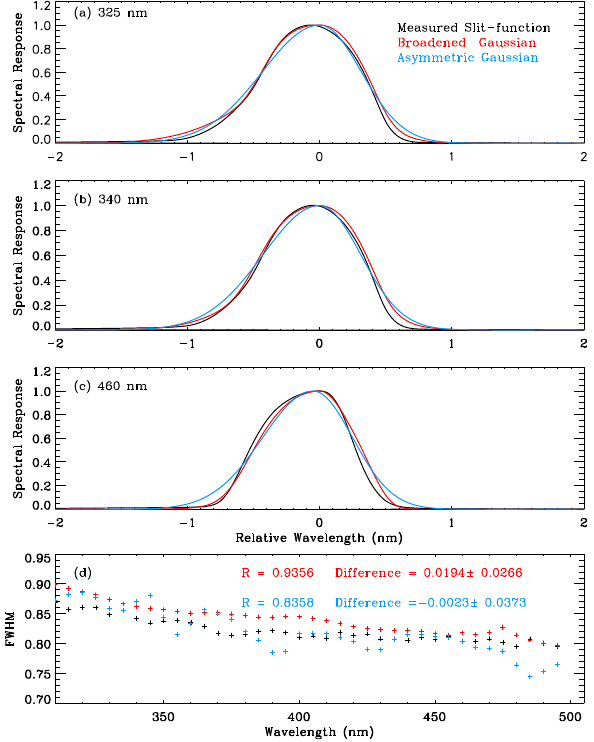
Figure 4. Comparison of derived ACAM asymmetric Gaussian (blue) and broadened Gaussian (red) slit functions with laboratory- measured slit functions (black) at (a) 325, (b) 340, and (c) 460nm, representing the O 3 , CH 2 O, and NO 2 fitting windows, respec- tively. The measured slit function has been shifted − 0.07 in (a) and 0.05nm in (b) , and the asymmetric Gaussian slit function has been shifted − 0.05nm in (c) . (d) Comparison of derived slit full width at half maximum (FWHM) as a function of wavelength. The correla- tions, mean differences, and 1 σ standard deviations with respect to the measured slit FWHMs are